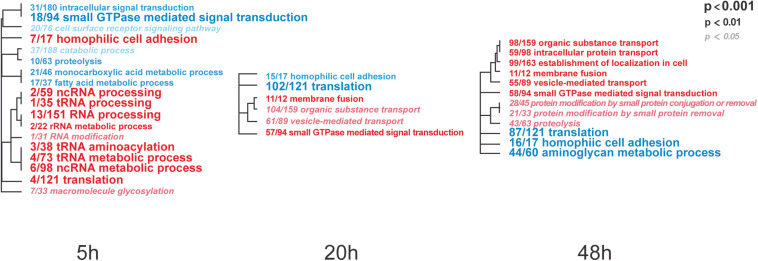
Overall trends in biological processes affected by progressing IAPV infection. Gene Ontology Mann-Whitney U tests of the expression differences between IAPV and control samples at the three time points included all data points regardless of their individual level of statistical significance. Red and blue fonts indicate GO terms that are enriched in up- and down-regulated DEGs in IAPV relative to control samples, respectively. Font size indicates the level of significance for the particular GO term and clustering is based on empirical GO-term similarity in our dataset.